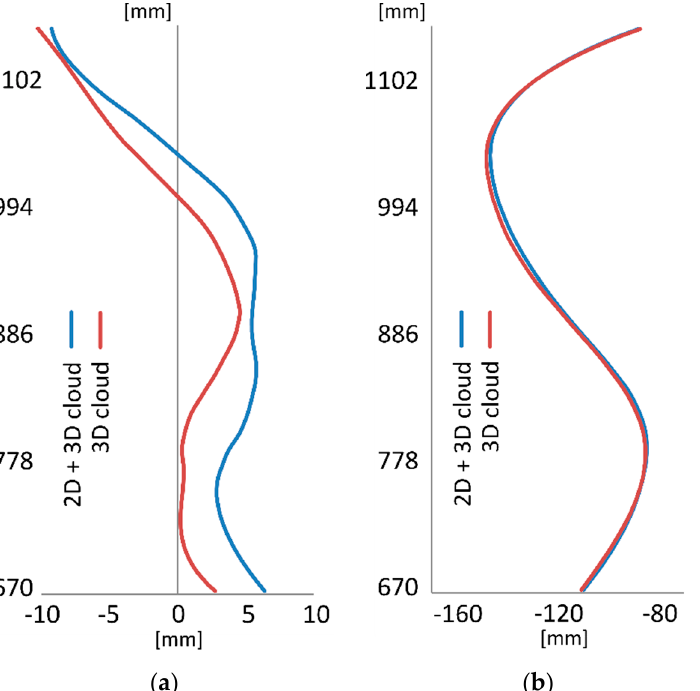
Figure 6. The graph showing the spinous processes line calculated using the developed methodology (X-ray and 3D ST scanning) and data obtained based on the 3D ST data analyses alone. Frontal ( a ) and sagittal ( b ) views. The ordinate and abscissa values are presented using different scales to visualize the abscissa axis data better.